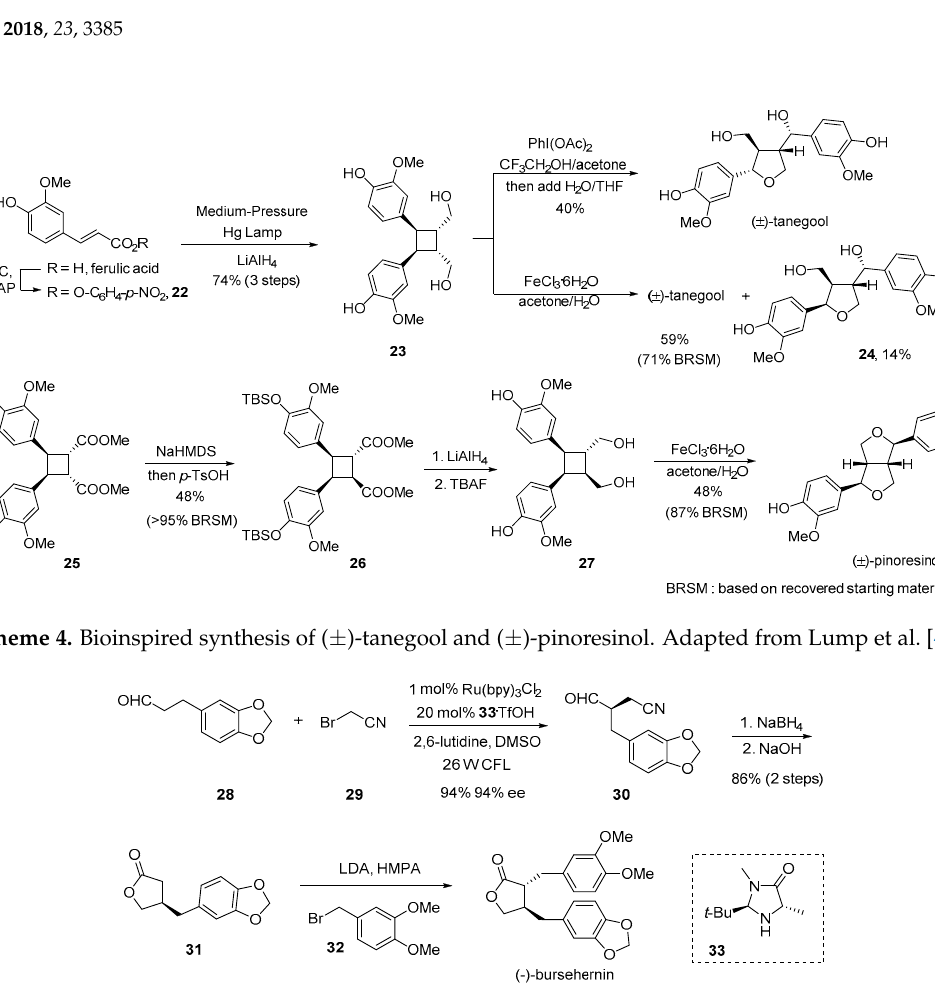
Molecules 2018 , 23 , x 3 of 22 Scheme 3. Synthesis of beilschmin A and gymnothelignan N. Adapted from She et al. [56]. She and coworkers reported the total synthesis of beilschmin A and gymnothelignan N in 2014 (Scheme 3) [56]. Alcohol 14 was prepared by hydroxyl protection of chiral amide 13 and subsequent reduction. Aldehyde 16 was obtained after homologation and reduction. The nucleophilic